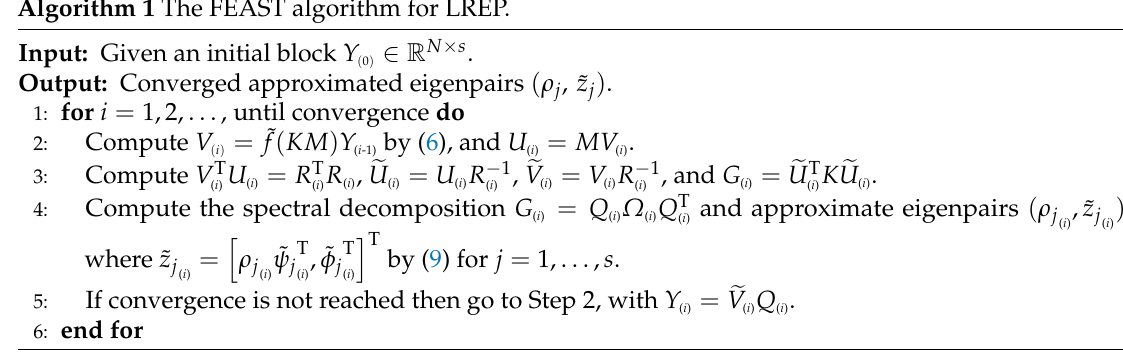
Algorithm 1 The FEAST algorithm for